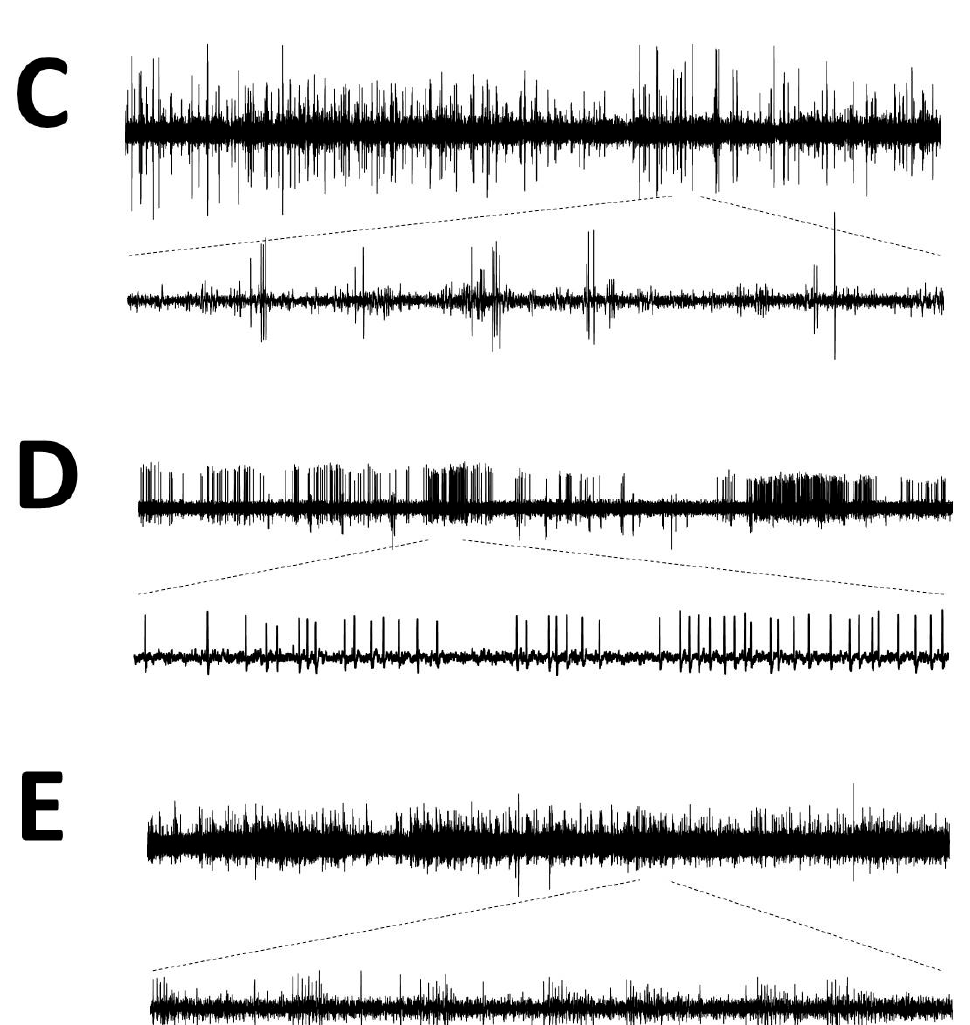
Figure A1. Raw traces from microelectrode recordings (MER) from different nuclei identified by reconstruction ( A ) Ce.pc; ( B ) Ce.mc; ( C ) V.im; ( D ) V.c and ( E ) DDNN. Horizontal calibration bar: 5 s for the upper traces and 167 ms for the lower traces.